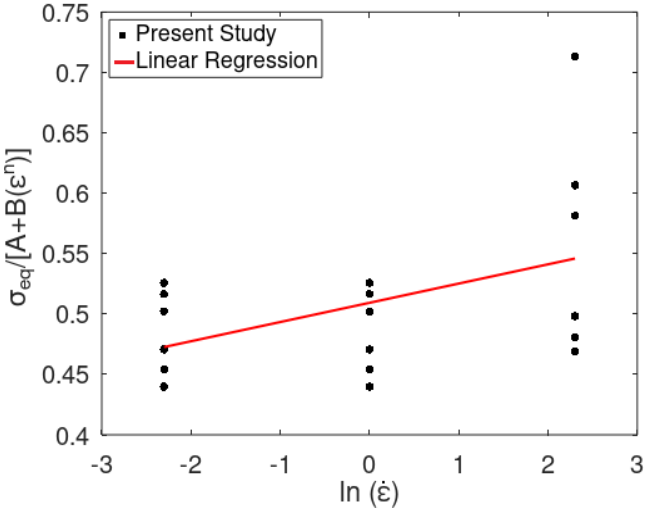
Figure 2. Curve fitting of true plastic stress-strain values at different strain rates to determine C. Further, for higher strain rates, SHPB simulation tests were performed with the incident, transmission and striker bars made of steel. The incident and transmission bars were 1500 mm in length with 16 mm diameter, as shown in Figure 3. The size of the specimen considered was 0.2 mm length with 10 mm diameter with slenderness ratio (length/diameter) maintained between 0.5 and 0.8.The velocity of the striker bar was maintained at 11.1 m/s [40].